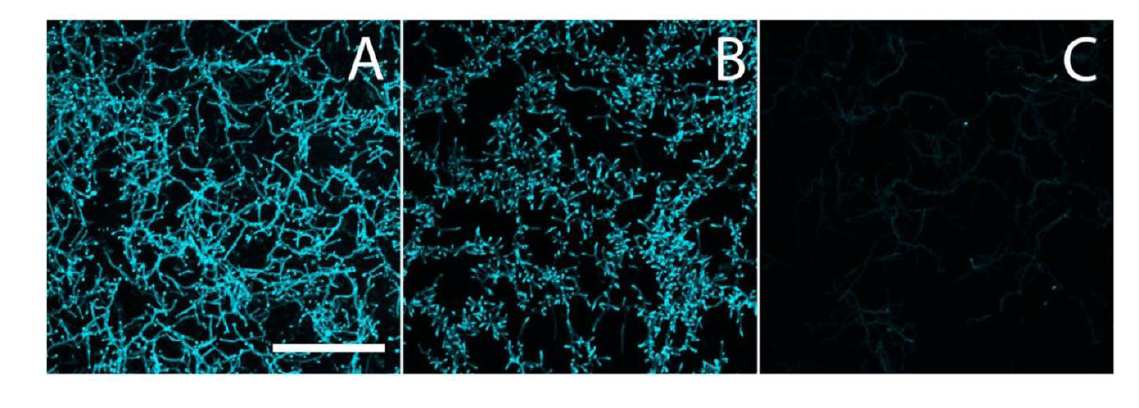
FIGURE 2: Calcofluor white staining to identify β-(1,4)-glycans . S. lividans (A) , and its matAB (B) and cslA (C) mutants were stained with calcofluor white (CFW) to identify the presence of extracellular β-(1,4)-glycans. The staining patterns indicated the presence of β-(1,4)- glycans in both the parental strain and its matAB mutant, but not in the cslA mutant. Bar, 50